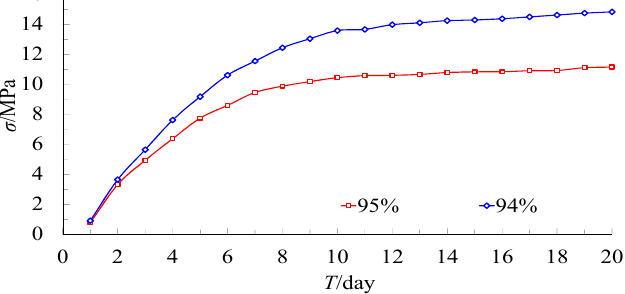
Figure 12. Critical deformation load characteristics of the specimens.